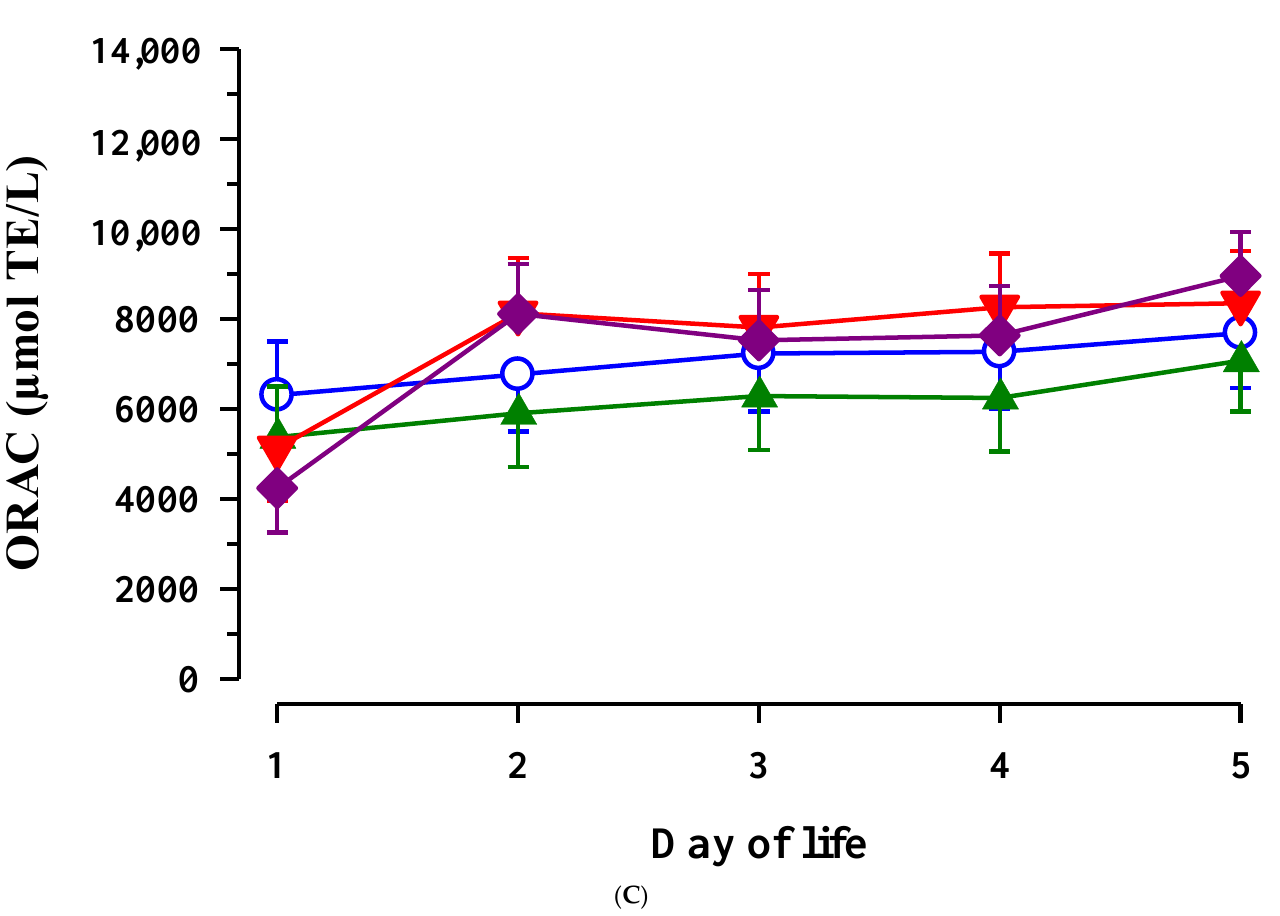
Figure 6. Plasma derivates of reactive oxygen metabolites (dROM) ( A ), ferric ion reducing anti-oxygen power (FRAP) ( B ) and oxygen radical absorbance capacity (ORAC) ( C ) in calves dependent on maternal fatty acid supplementation ( ○ control, CON n = 9; ▲ EFA, essential fatty acids, n = 9; ▼ , CLA, conjugated linoleic acid, n = 9; ♦ , EFA + CLA, n = 11) and time after birth. Day 1 corresponded to the day of birth. ab Different superscripts mark differences between groups at similar time points ( p < 0.05). X designates significant differences between calves with maternal EFA supplementation and without maternal EFA supplementation at similar time points and Y between calves with and without maternal CLA supplementation ( p < 0.05).